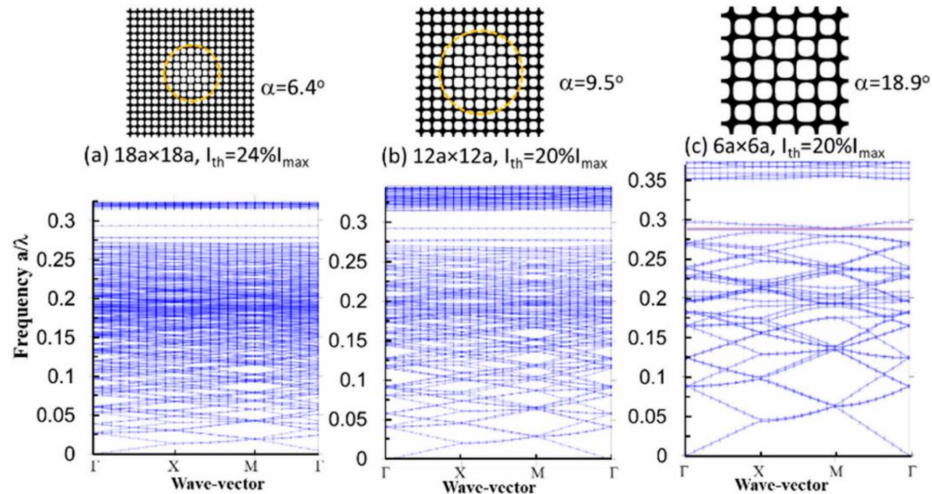
Figure 3. (Top row) Iso-intensity slices produced from the eight-beam interference at certain threshold intensity with twist angles of 6.4 ( a ), 9.5 ( b ), and 18.9 degrees ( c ) and used as a unit super-cell to calculate the respective photonic band structures for TE modes (bottom row) at z -locations around 0.4 P z